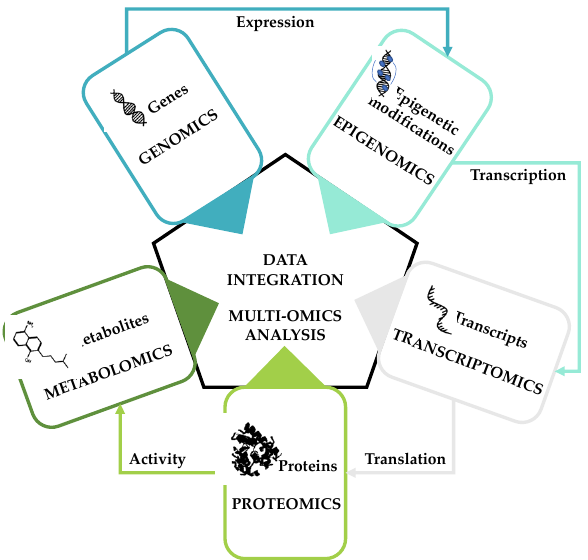
Figure 1. Schematic representation of the most commonly used omic platforms for multi-omics studies.